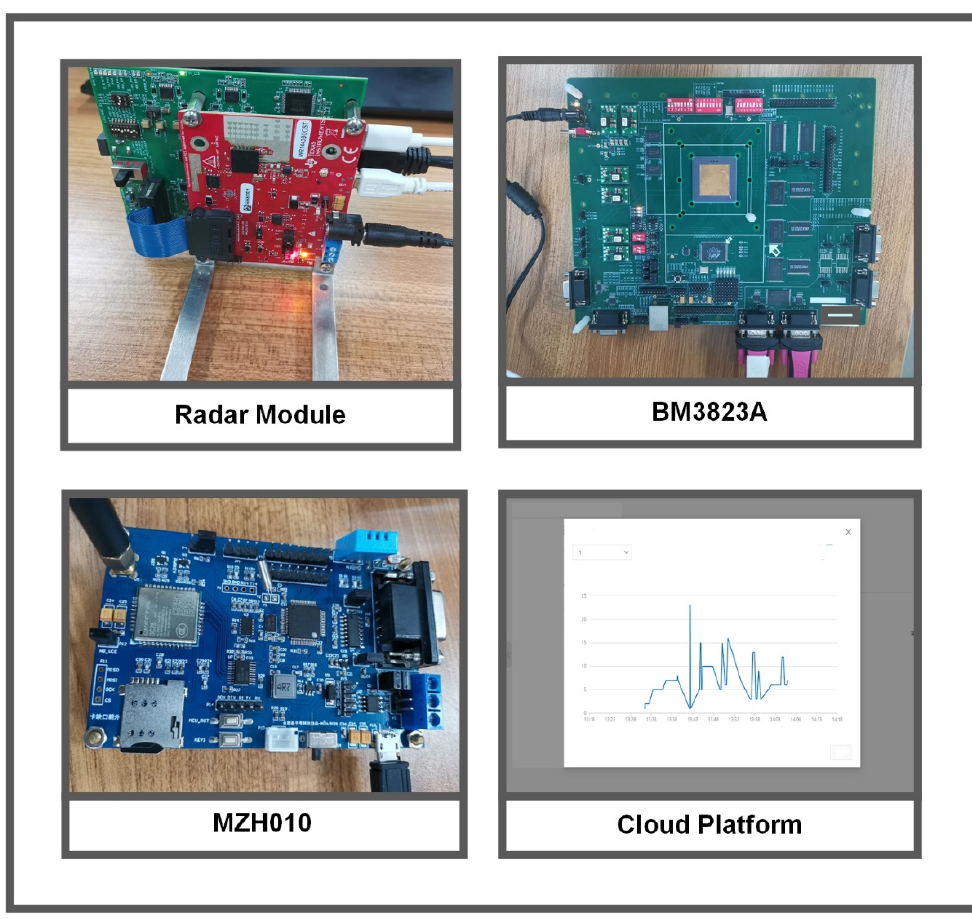
Figure 6. Measurement modules of the system.